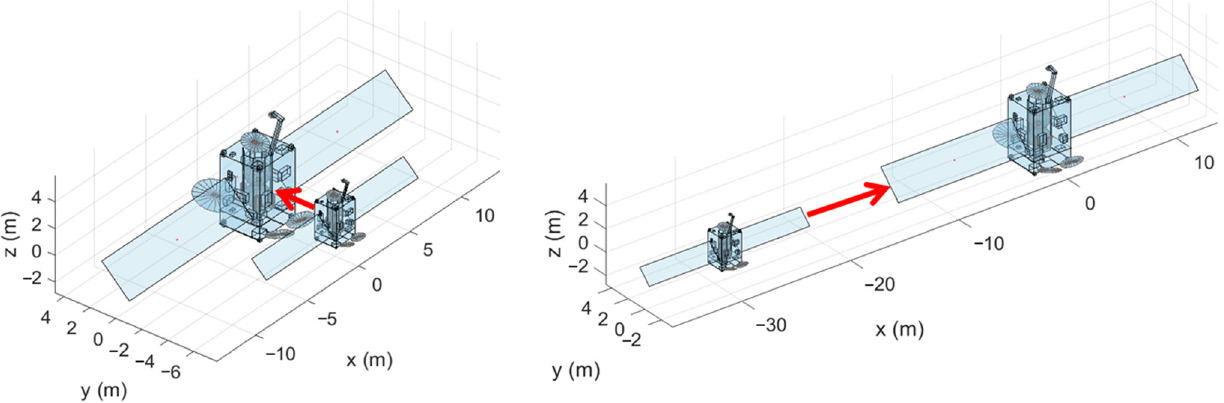
Figure 14. Simulated collision scenarios: central impacts ( left ) and collisions on the appendages ( right ).